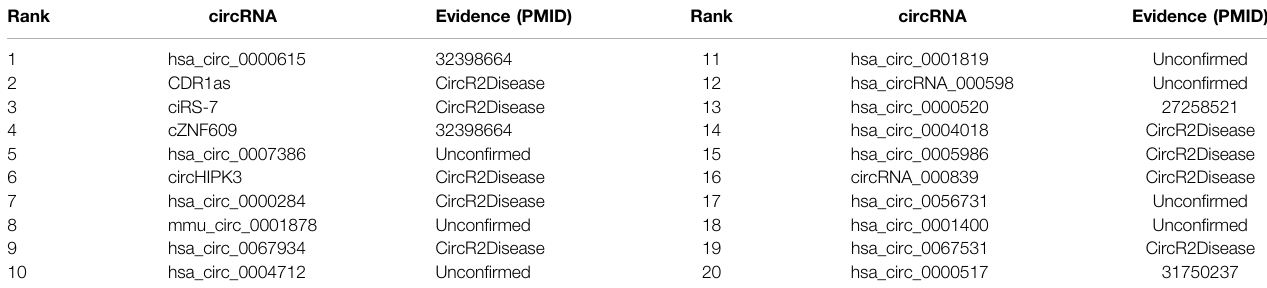
TABLE 5 | The top 20 hepatocellular carcinoma-related candidate circRNA.